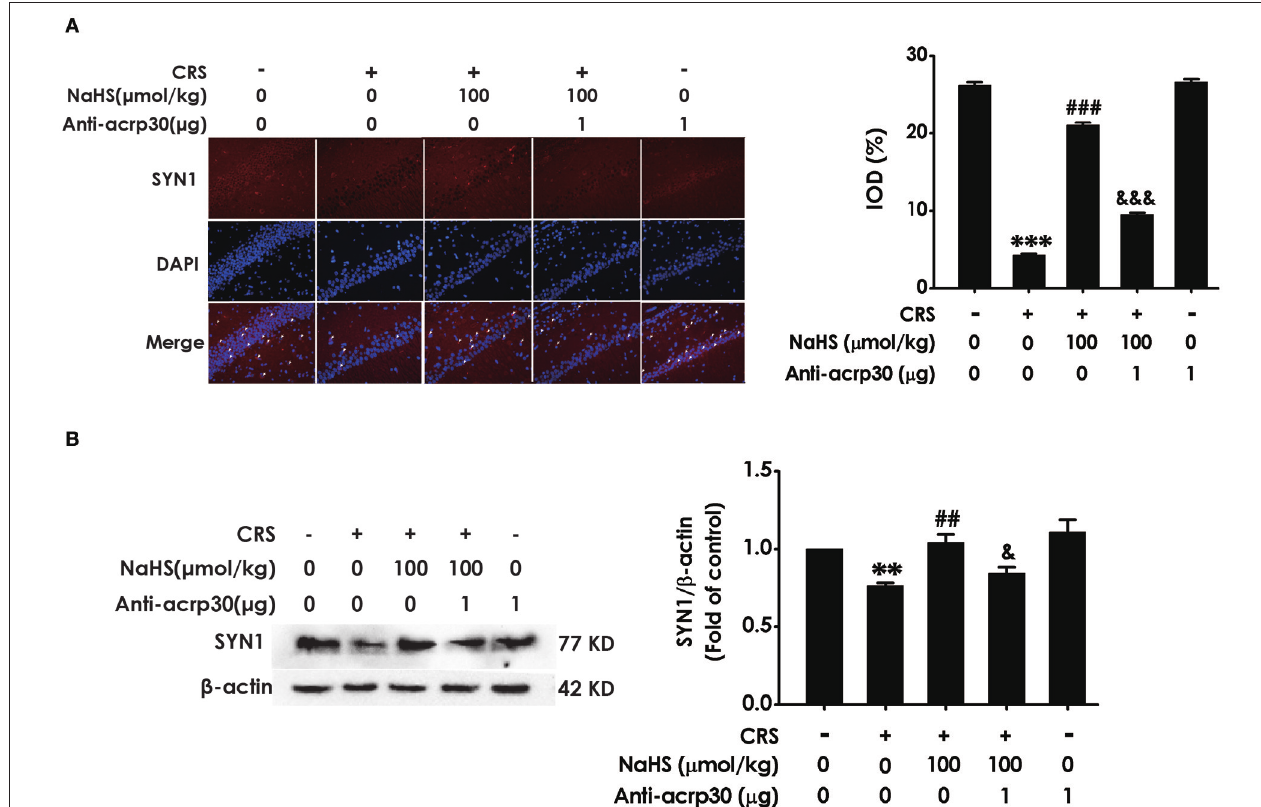
FIGURE 7 | Effect of Anti-acrp30 on H 2 S-alleviated synapse formation disorder in CRS-exposed rats . After cotreatment with CRS and NaHS (100 µ mol/kg, i.p.) for 3w, SD rats were further co-administrated with Anti-acrp30 (1 µ g/d, icv) for 1w. The levels of hippocampal SYN1 were analyzed by immunofluorescence technique [ (A) , magnification × 400] and western blot (B) . β -actin was used as an internal control. Values are expressed as means ± SEM ( n = 3). ** P < 0.01, *** P < 0.001, vs. control group; ## P < 0.01, ### P < 0.001, vs. CRS-treated alone group, & P < 0.05, &&& P < 0.001, vs. cotreated with CRS and NaHS (100 µ mol/kg, i.p.)